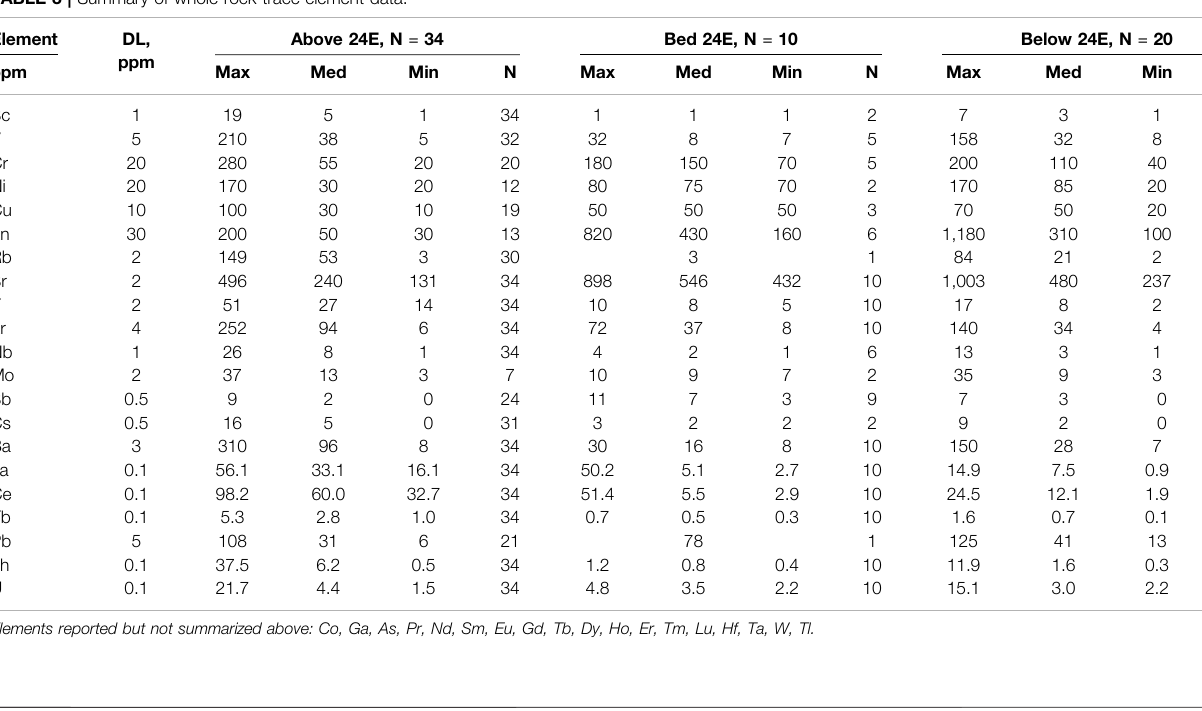
Frontiers in Earth Science |